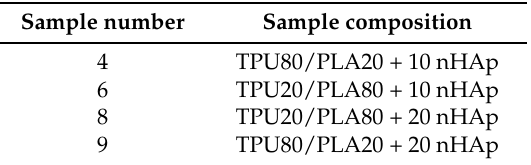
Table 3. The composition and numbers of biomaterial samples used in the in vitro